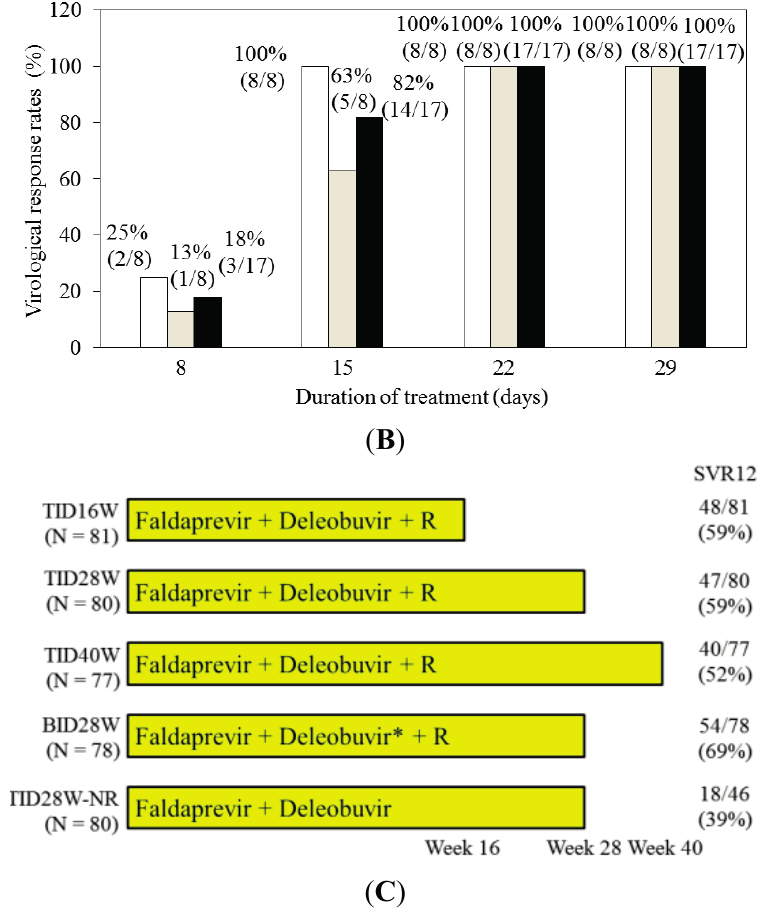
Figure 4. Safety and antiviral effect of Oral combinations withoUt iNnterferon in patients Diagnosed with chronic hepatitis C (SOUND) trial designs and results. ( A , B ) The clinical phase 1b trial (SOUND-C1) consisted of faldaprevir in combination with deleobuvir and ribavirin for 4 weeks in treatment-naive patients with chronic genotype 1 HCV [28]. ( A ) In patients treated with deleobuvir 400 mg 3 times daily + faldaprevir 120 mg once daily + ribavirin, virological response (HCV RNA level less than 25 IU/mL) by the duration of treatment and genotype. White column, HCV subgenotype 1a; gray column, HCV subgenotype 1b; black column, HCV subgenotypes 1a and 1b; ( B ) In patients treated with deleobuvir 600 mg 3 times daily + faldaprevir 120 mg once daily + ribavirin, virological response (HCV RNA level less than 25 IU/mL) by the duration of treatment and genotype; ( C ) In the clinical phase 2b trial (SOUND-C2) [29], treatment regimens were as follows: faldaprevir at a dose of 120 mg once daily and deleobuvir at a dose of 600 mg three times daily, plus ribavirin (R), for 16, 28, or 40 weeks (TID16W, TID28W, or TID40W, respectively); faldaprevir at a dose of 120 mg once daily and deleobuvir at a dose of 600 mg twice daily*, plus ribavirin (R), for 28 weeks (BID28W); and faldaprevir at a dose of 120 mg once daily and deleobuvir at a dose of 600 mg three times daily, without ribavirin, for 28 weeks (TID28W-NR). The rates of sustained virological response 12 weeks after therapy (SVR12) are